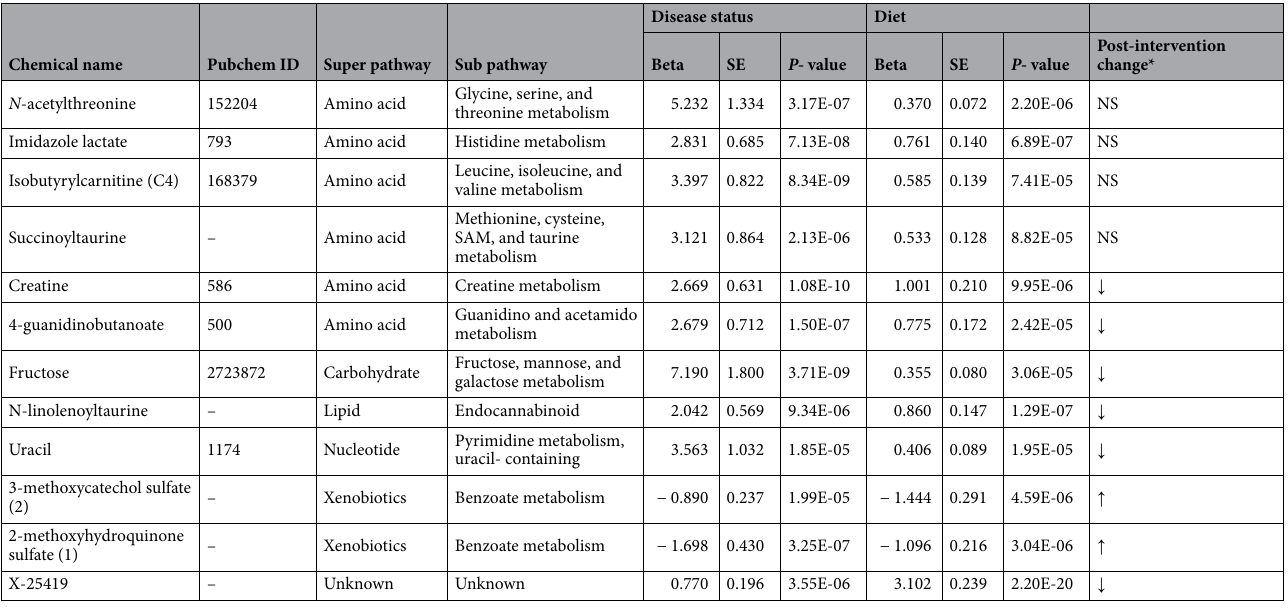
Table 2. Metabolites that overlapped in comparisons of metabolites that differed by diet and metabolites that differed by disease in 75 dogs (46 dogs with DCM [non-traditional (NT) diet, n = 38; traditional (T) diet, n = 8] and 29 healthy controls [NT diet, n = 12; T diet, n = 17]). After merging these two datasets, 12 metabolites overlapped both comparisons. Positive beta values indicate higher levels in dogs with DCM (for disease status) and in dogs eating NT diets (for diet status). Of 38 DCM-NT dogs enrolled in the 9-month intervention, 20 were alive for the 9-month post-intervention analysis (See also Supplementary Table S5). Six of the ten metabolites that were higher in the DCM-NT group at baseline decreased significantly between baseline and post-intervention analysis. Key: SE standard error, SAM S-adenosyl methionine, *significant change from baseline to 9-month post-intervention analysis after change to intervention diet ( ↓ significant decrease; ↑ significant increase; NS change not significant).